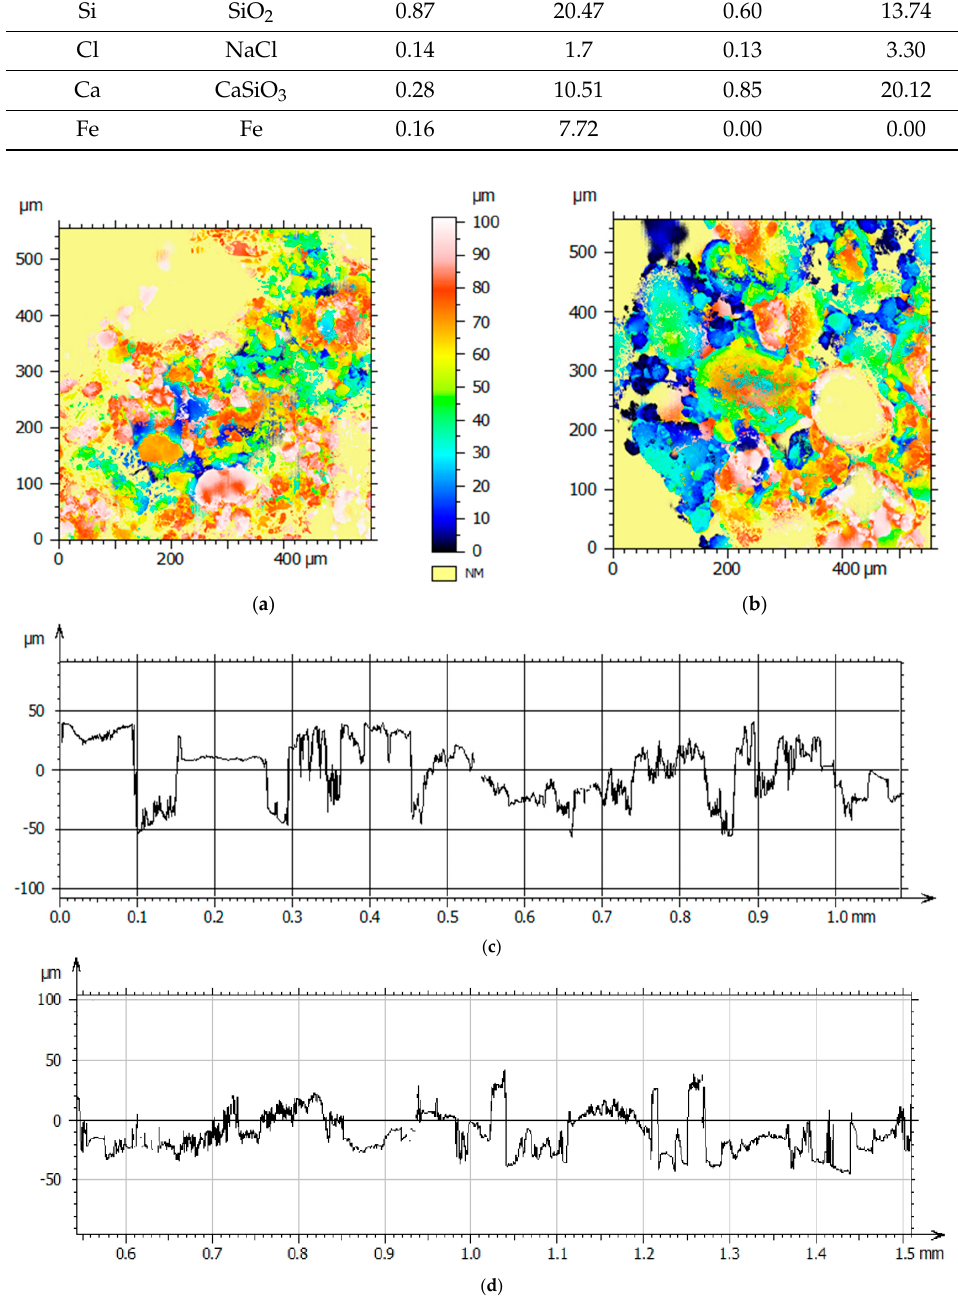
Figure 4. Scanned surfaces of ( a ) sample A and ( b ) sample B using confocal microscopy and 2D surface topographies of ( c ) sample A and ( d ) sample B. Dynamic triaxial testing (ASTM D3999-91 [41]) and monotonic triaxial loading (ML) are performed with a dual mode cyclic triaxial test apparatus supplied by VJ Tech (UK). CT equipment also includes BE fixed to the top and bottom platens with independent controls. All tests are conducted under two confining pressures ( σ 3 ) of 150 kPa and 300 kPa. Identical specimens with similar void ratios are produced for CT and ML tests from the two types of sands. Continuous BE measurements are taken during ML tests at regular